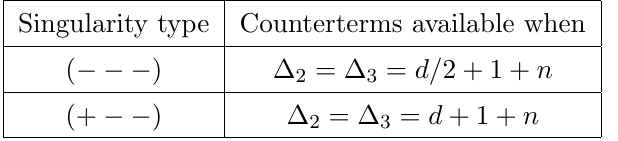
Table 4 . Availability of counterterms for h T (cid:22)